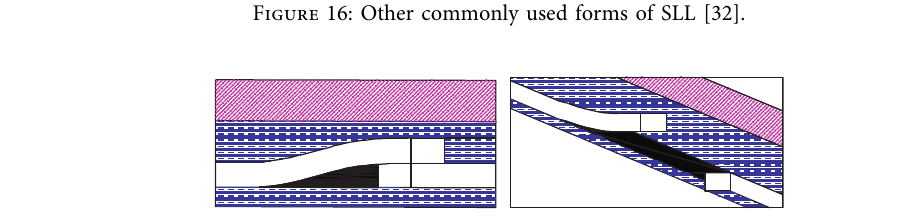
Figure 17: SLL tailgate excavated in roof rock in thin coal